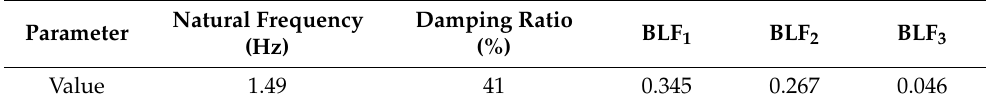
Table 3. Physical parameters of the bouncing person.